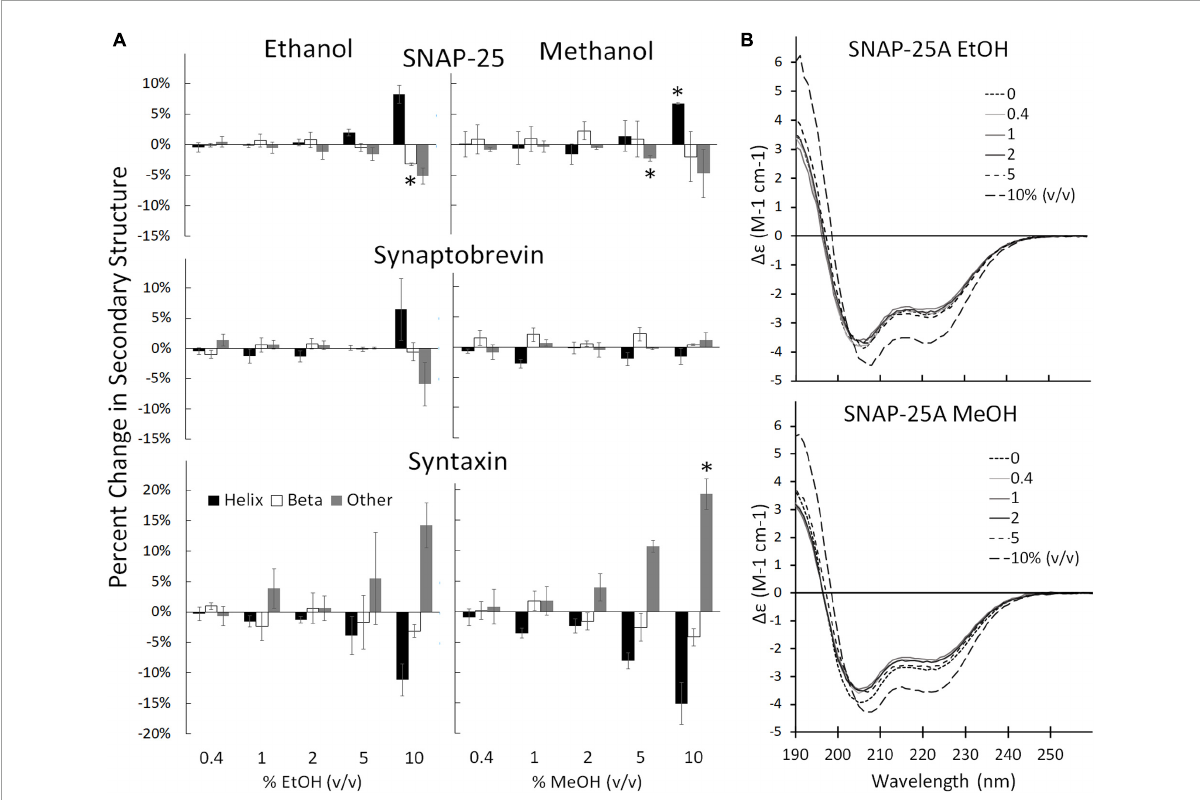
FIGURE3 Secondary structure changes of the three SNARE proteins as determined by CD spectrometery. (A) Shows the SNARE proteins (from top to bottom: SNAP-25, syb2, and syx) when treated with ethanol (left) and methanol (right). The three SNARE proteins show no change in their secondary structure significantly at the low ethanol doses seen to cause significant functional effects in the SNARE-driven fusion assay. An alcohol-induced change in secondary structure is only significant at 10% for syx and above 5% v/v for SNAP-25. (B) Shows representative CD spectra of SNAP-25 with increasing doses of ethanol (top) and methanol (bottom). Similar spectra were obtained with syx and syb2 ( Supplementary Figures 2, 3 respectively). Error bars are SEM, ∗ p < 0.05 using two-tailed Student’s t -test. n = 2 for all 10% doses. n = 2–4 for all other